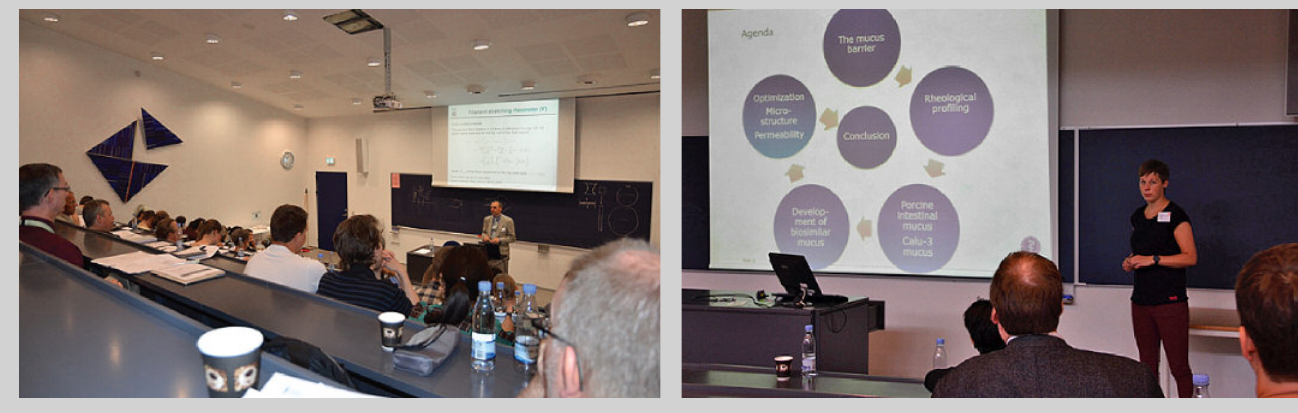
© Appl. Rheol. 23 (2013) 309